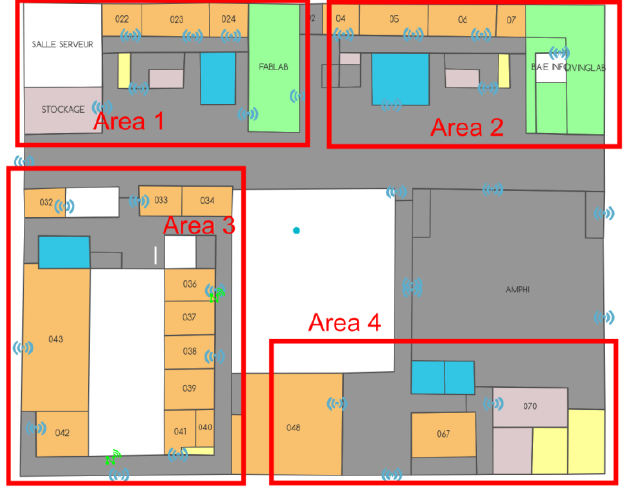
Figure 8. “ Area n aming”. Figure 8. “Area naming”.